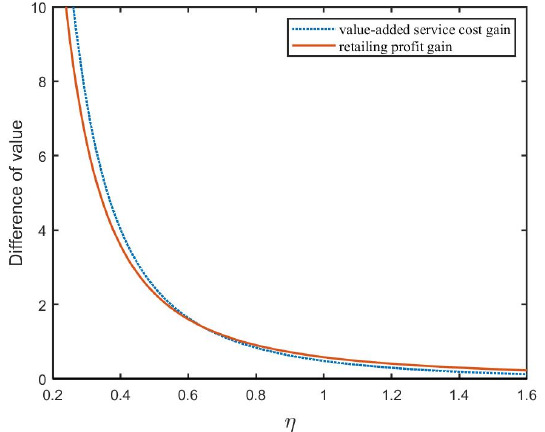
Figure 9. Impact of η on the retailer’s values in scenario N . ( α = 2.2, φ = 0.68).